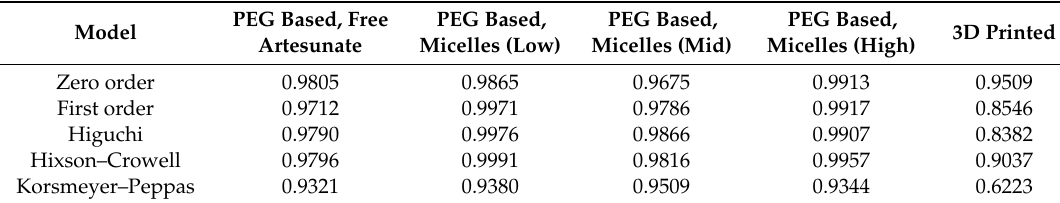
Table 3. Comparison of the correlation coe ffi cient ( R 2 ) for the release kinetics of artesunate using di ff erent mathematical models.